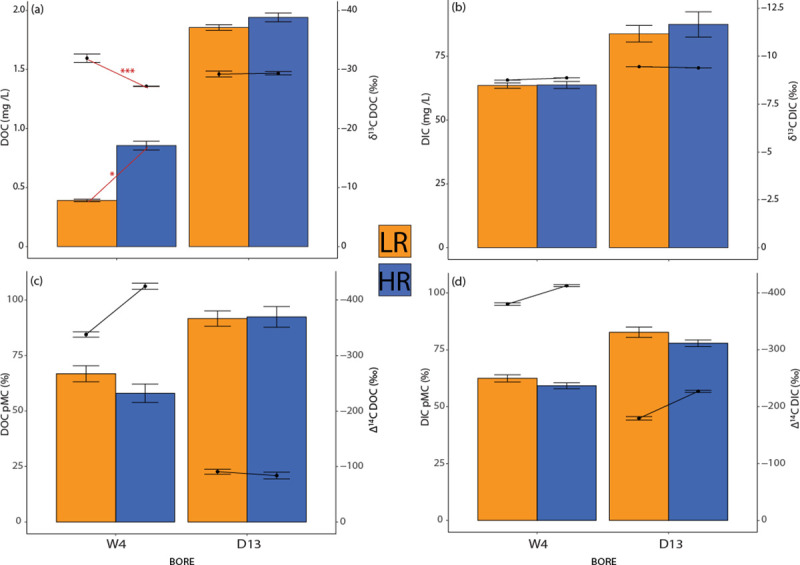
Bar charts illustrating DOC and DIC concentrations (a and b), and respective percent of modern carbon (pMC, with modern defined as 1950) (c and d) from the bores W4 and D13 across LR (dark yellow) and HR (blue). The whiskers of the bars refer to standard deviation values. Combined line graphs refer to δ13C DOC (a), δ13C DIC (b), Δ14C DOC (c) and Δ14C DIC (d). * significant trend with P value < 0.05; ** significant trend with P value < 0.005; *** significant trend with P value < 0.0005. Refer to S1 Table for the specific values of the parameters.